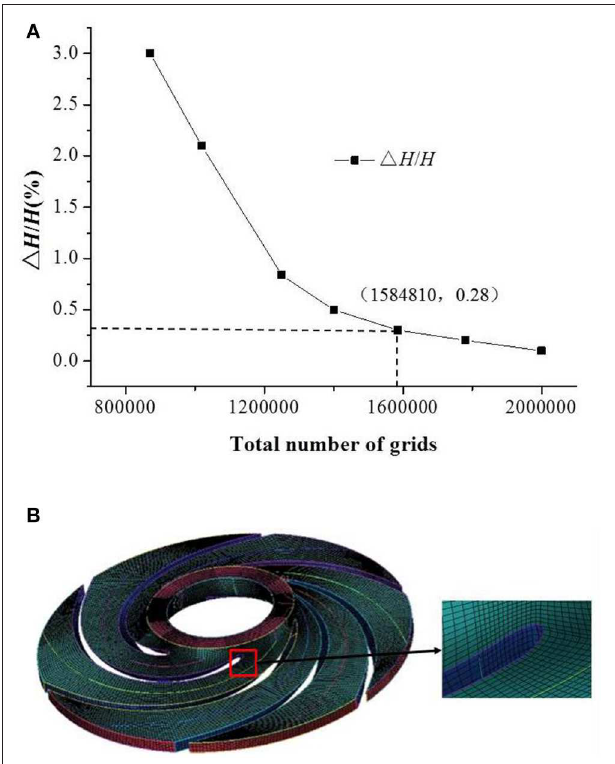
FIGURE 3 | Meshing. (A) Grid independence verification and (B) structured grid of impeller.